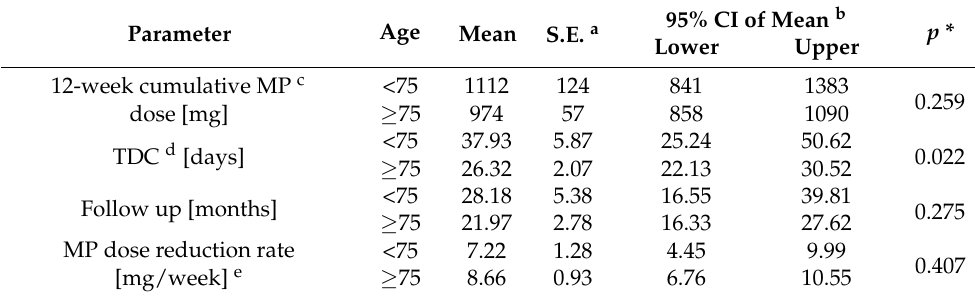
Table 2. Central parameters of the therapeutic response: Comparison between ‘younger’ (<75-years- old, n = 14) and ‘older’ ( ≥ 75 years old, n = 39)